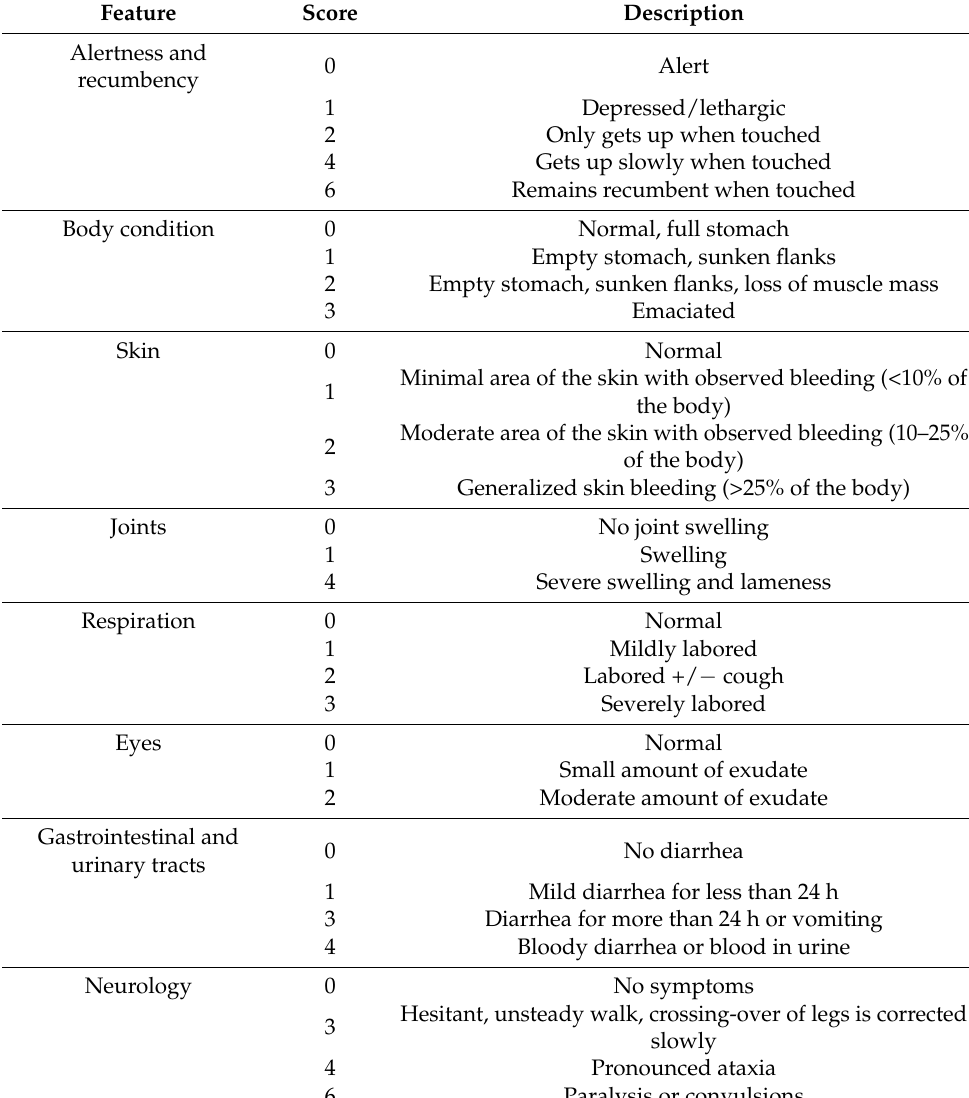
Table 1. Description of clinical score